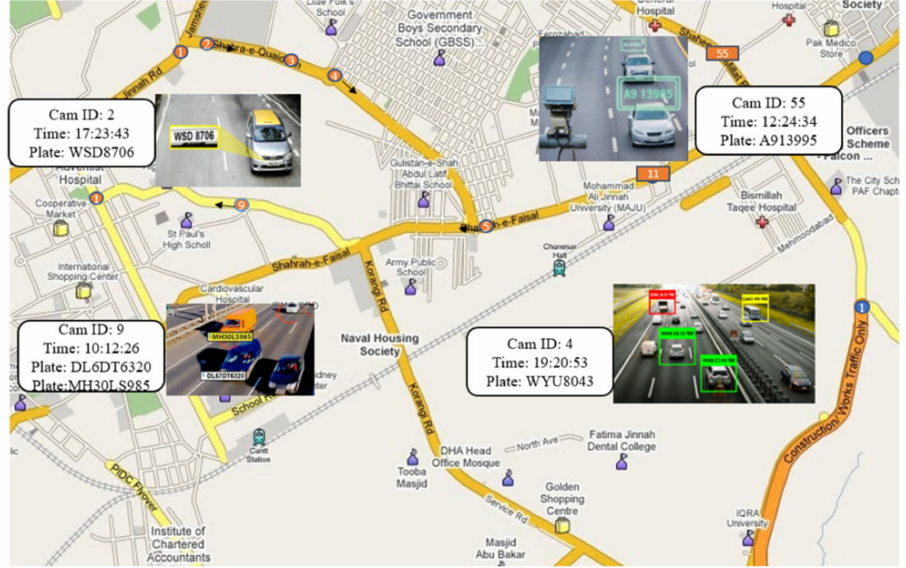
Figure 16. Depicts the spatio-temporal information.